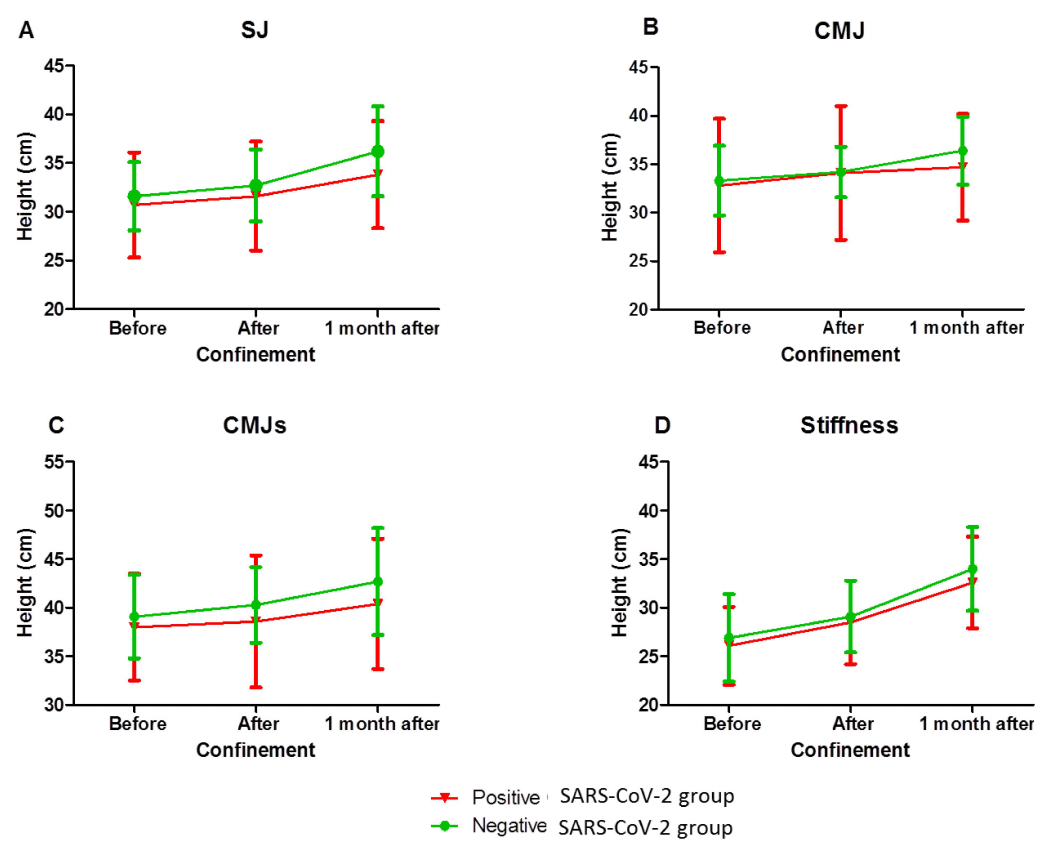
Figure 2. Jump parameter evolution before, after and at 1 month of the COVID-19 confinement in players who had SARS-CoV-2 infection (red line) or not (green line). ( A ) SJ parameters (cm) evolution; ( B ) CMJ parameters (cm) evolution; ( C ) CMJs parameters (cm) evolution; ( D ) stiffness parameters (cm)